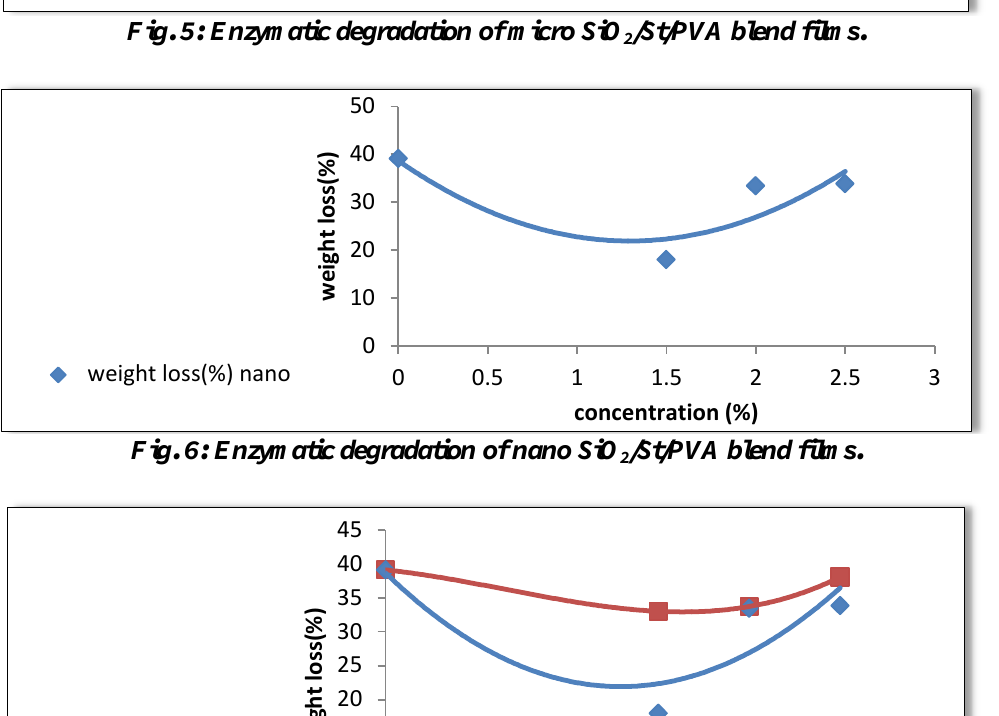
Fig. 5: Enzymatic degradation of micro SiO